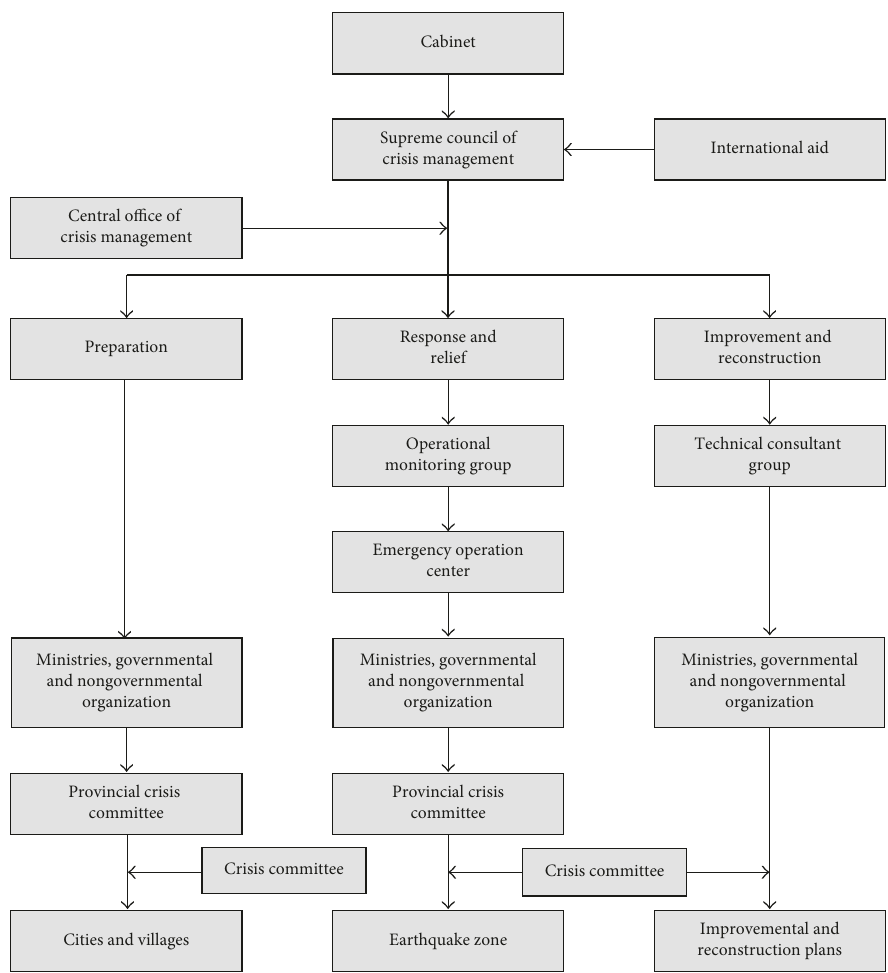
Figure 1: Sample organizational and operational system in crisis